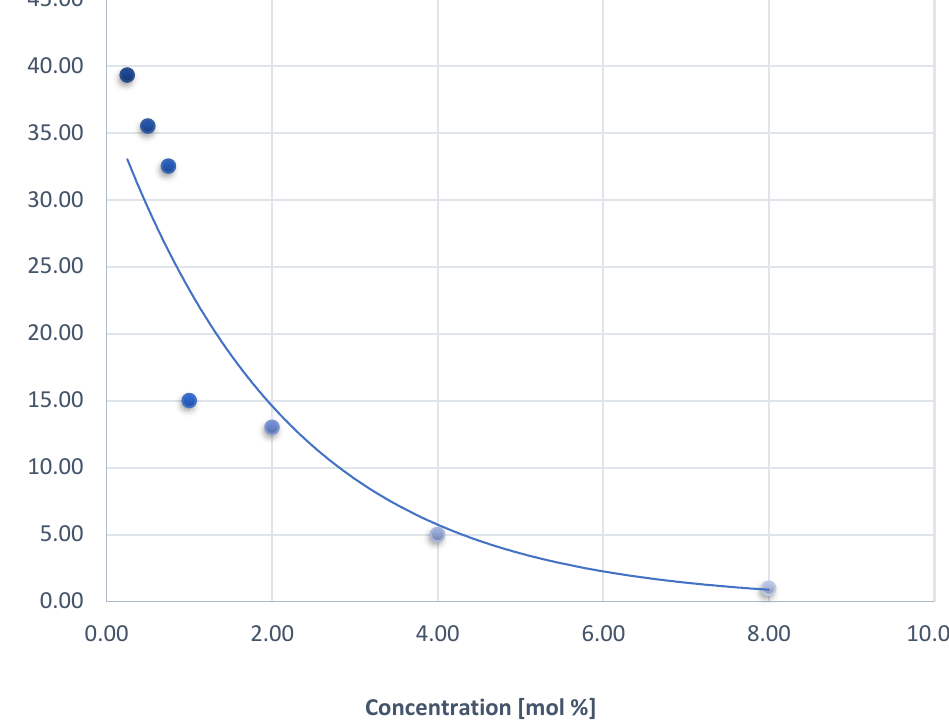
Figure 7. EPR concentration dependence of asymmetry parameter.